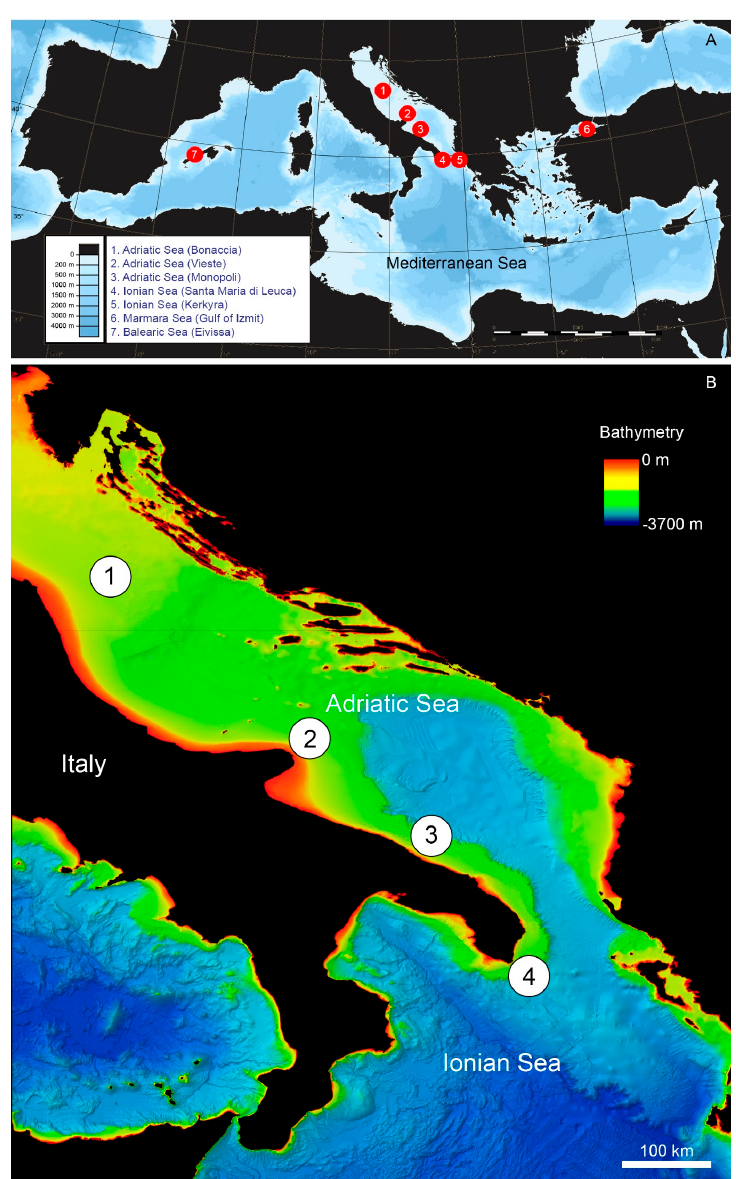
Figure 1. ( A ) Location map of Mediterranean Neopycnodonte cochlear reefs (red dots) targeted by ROV surveys and discussed in the text; also shown are sites in the SE Adriatic (Greece, Kerkyra), Marmara Sea (Gulf of Izmit) and Baleares (o ff Eivissa) which produced compelling evidence of such oyster aggregations through bottom sampling. ( B ) Close-up of the SW Adriatic and N Ionian areas with localisation of main reef sites there. Bathymetry from